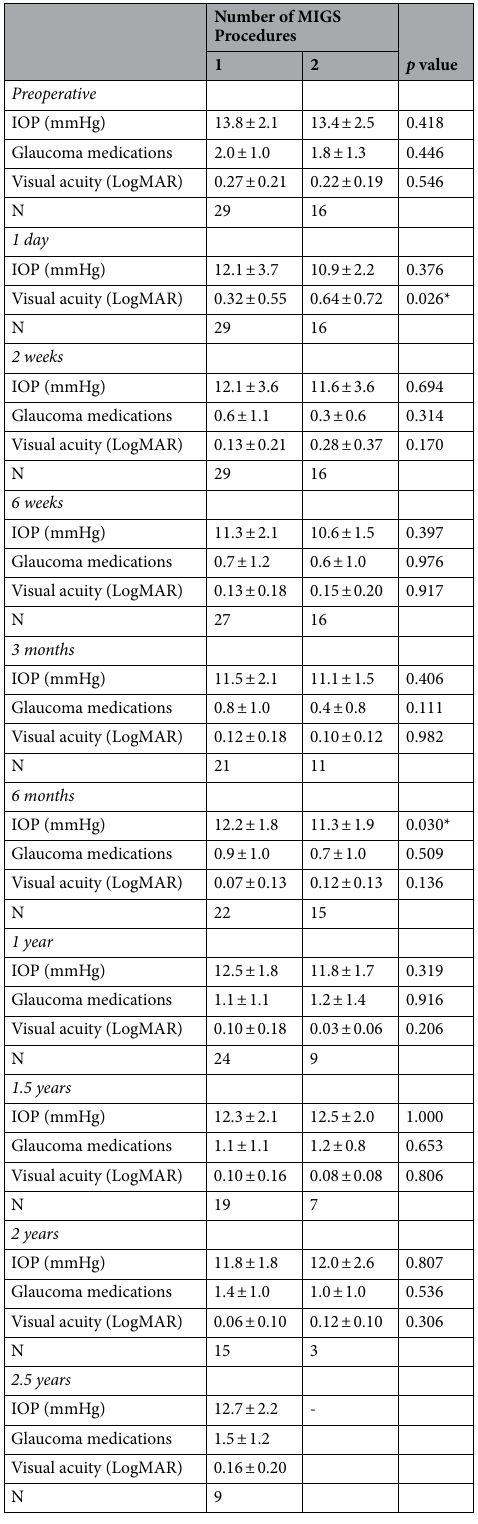
Table 5. Intraocular pressure, medication burden, and visual acuity outcomes data stratified by 1 or 2 MIGS procedures. IOP = intraocular pressure; mmHg = millimeters of mercury; LogMAR = logarithm of the Minimum Angle of Resolution; N = number of eyes; SD = standard deviation. a Patients with LP or NLP at these time points were excluded in mean and p value calculations due to a lack of a validated LogMAR